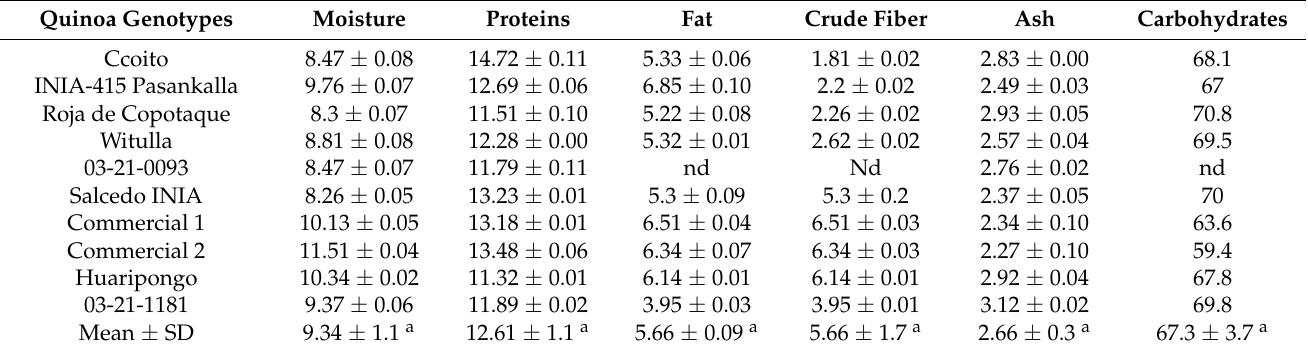
Table 2. Proximate composition of quinoa grains (g/100 g)